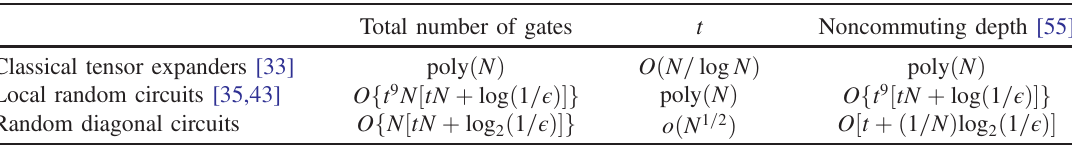
TABLE I. A comparison between quantum circuit constructions of unitary t -designs on N qubits, which works for t ≥ 3 . The total number of quantum gates to achieve classical tensor expanders is known to be poly ð N Þ , but is not explicitly presented in Ref. [33]. The noncommuting depth was introduced in Ref. [55] and is defined by the circuit depth when each commuting part of the circuit is counted as one step. The noncommuting depth may be of experimental